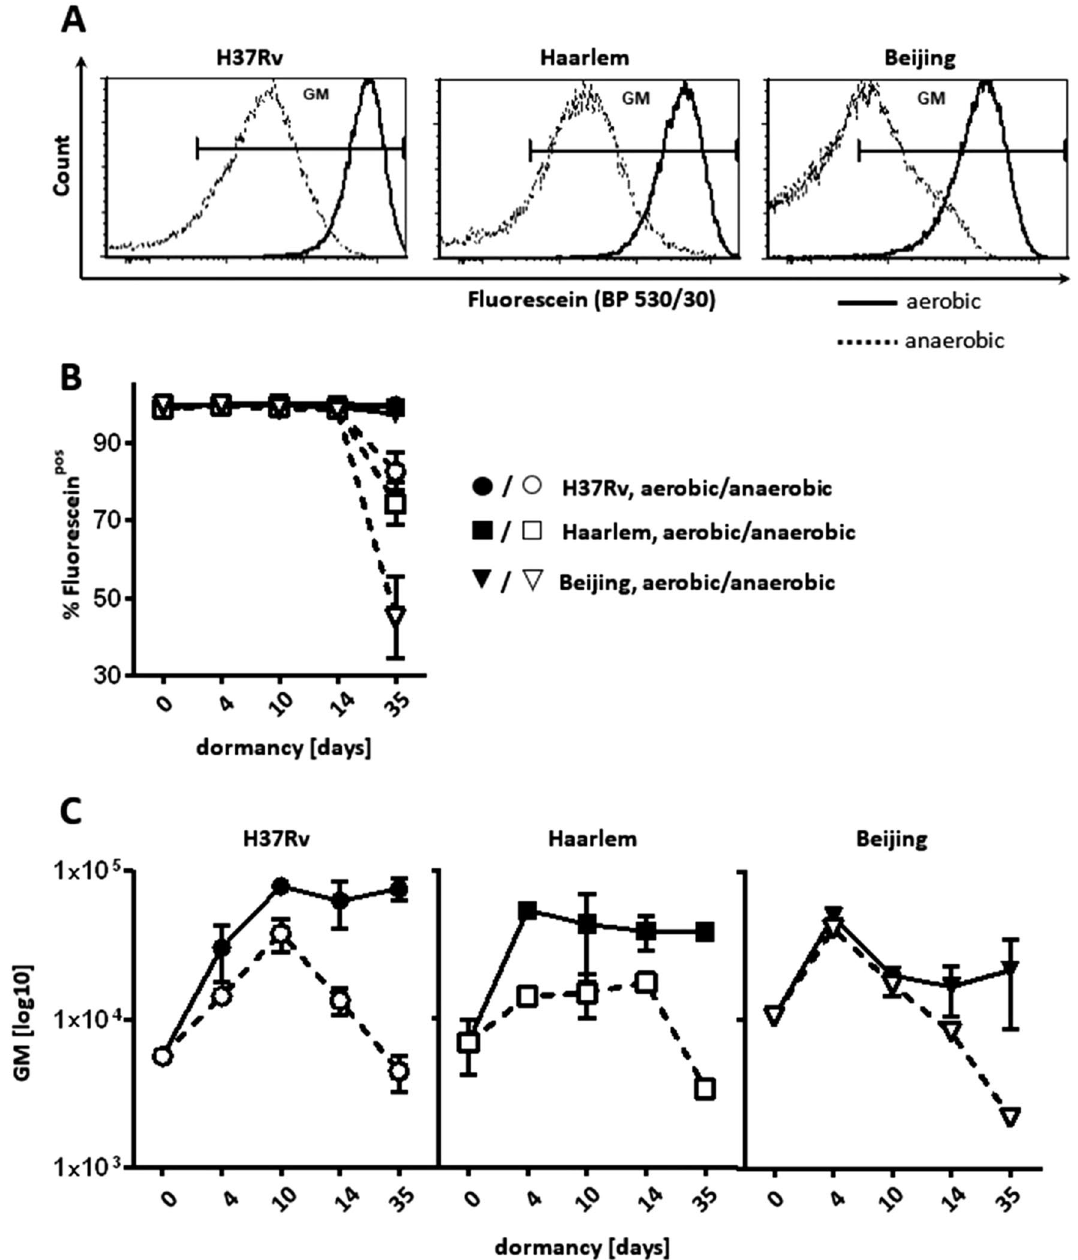
Figure 2. Gradual loss of metabolic activity during dormancy (d0–d35). Example of a histogram of fluorescin- positive mycobacteria at d35 of dormancy after incubation at 37 °C with FDA for 20 min ( A ). Per cent of fluorescein-positive cells ( B ) and geometric mean (GM) fluorescence intensity ( C ) of mycobacterial strains within gate GM were measured at indicated time points. One representative experiment (triplicates) out of two is